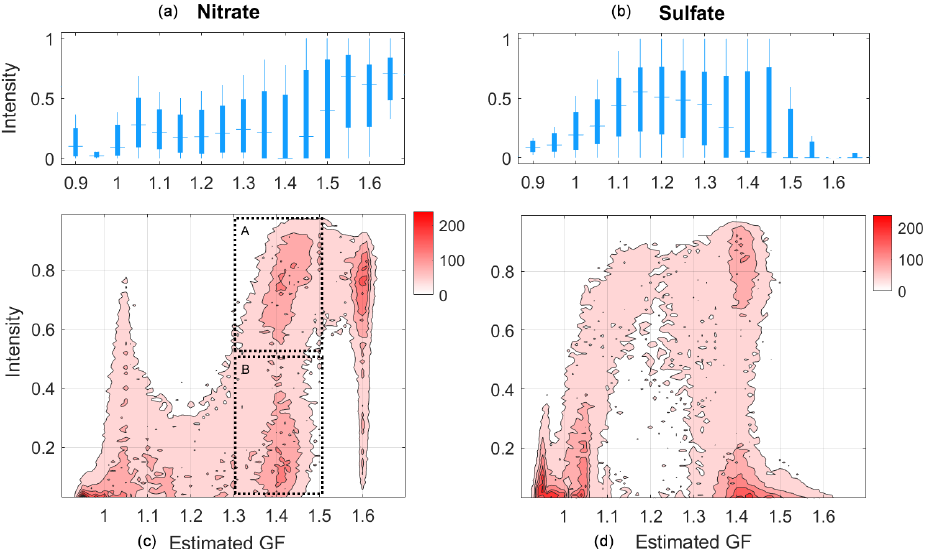
Figure 10. Statistics (minimum, 25th percentile, median, 75th percentile, maximum) on the nitrate and sulfate peak intensities of ambient particles at different GFs (a–b) . Particle number distributions as a bivariate function of estimated GF and peak intensities of nitrate and sulfate (c–d) .